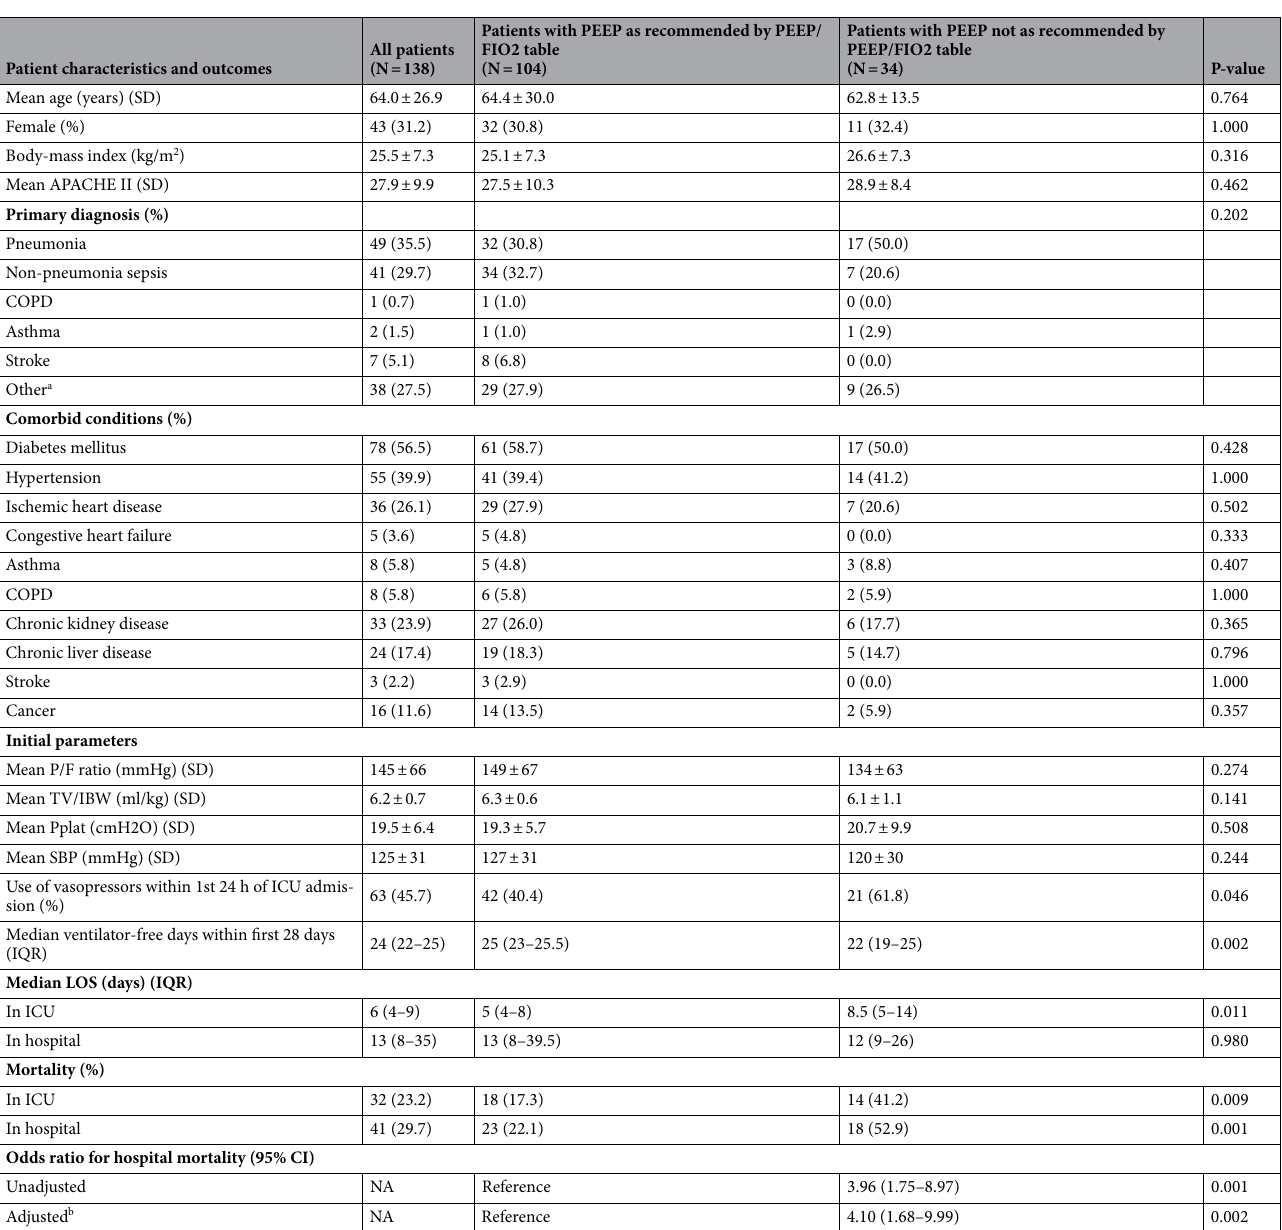
Table 2. Patient characteristics and outcomes, by adherence to low PEEP/FIO2 table. APACHE Acute Physiology and Chronic Health Evaluation, CI Confidence interval, COPD Chronic obstructive